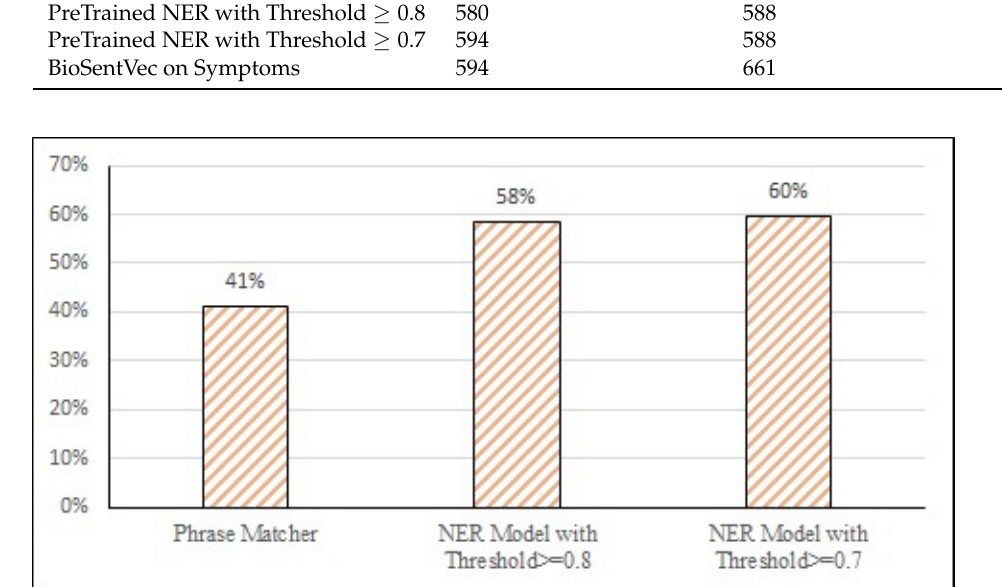
Figure 10. Chart showing the percentage of scraped diseases interlinked with disease ontology using different adopted